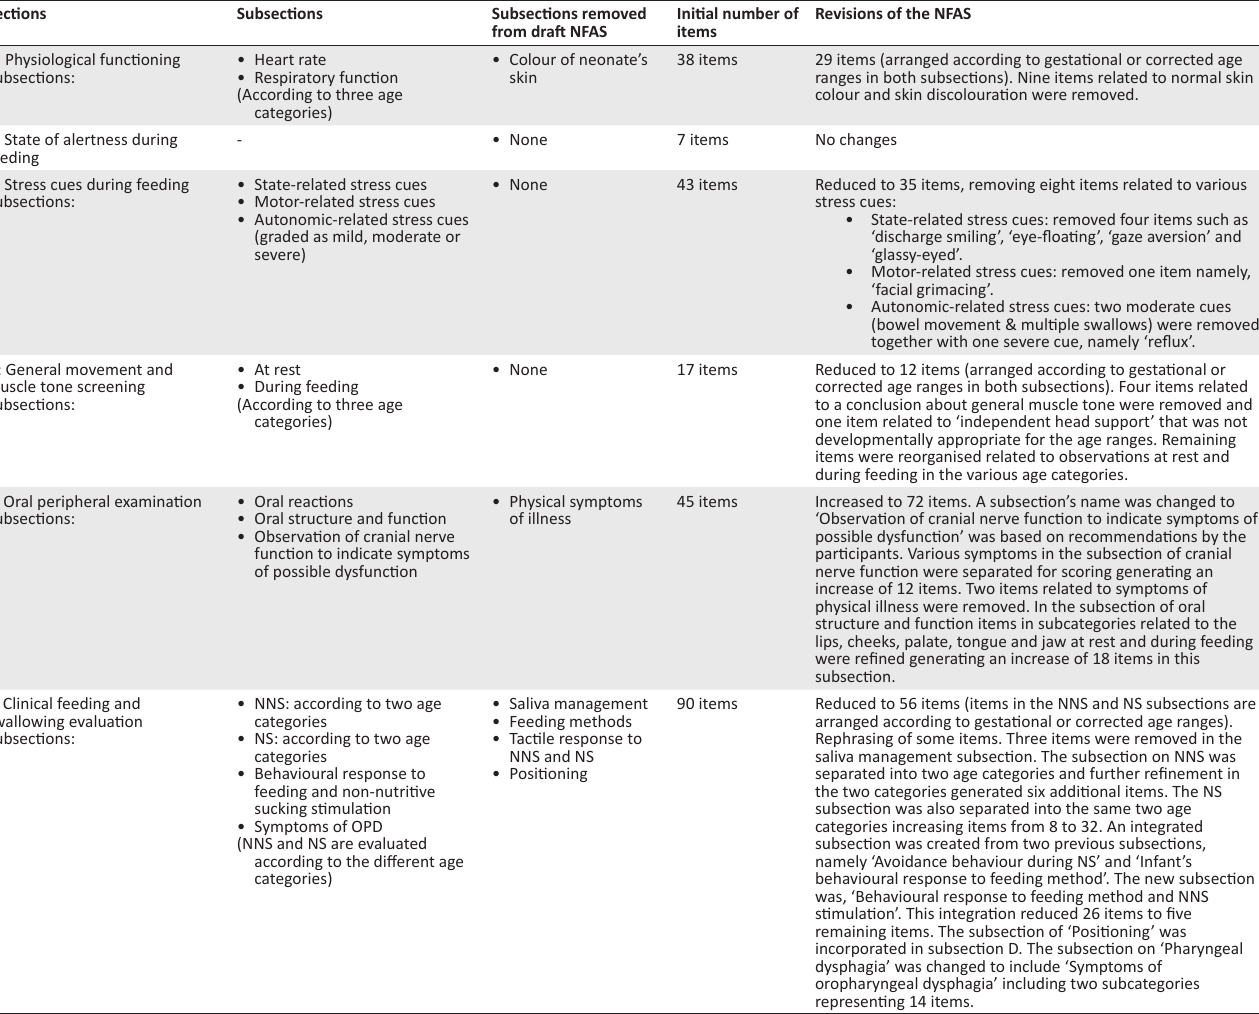
TABLE 6: Overview of the final Neonatal Feeding Assessment Scale.